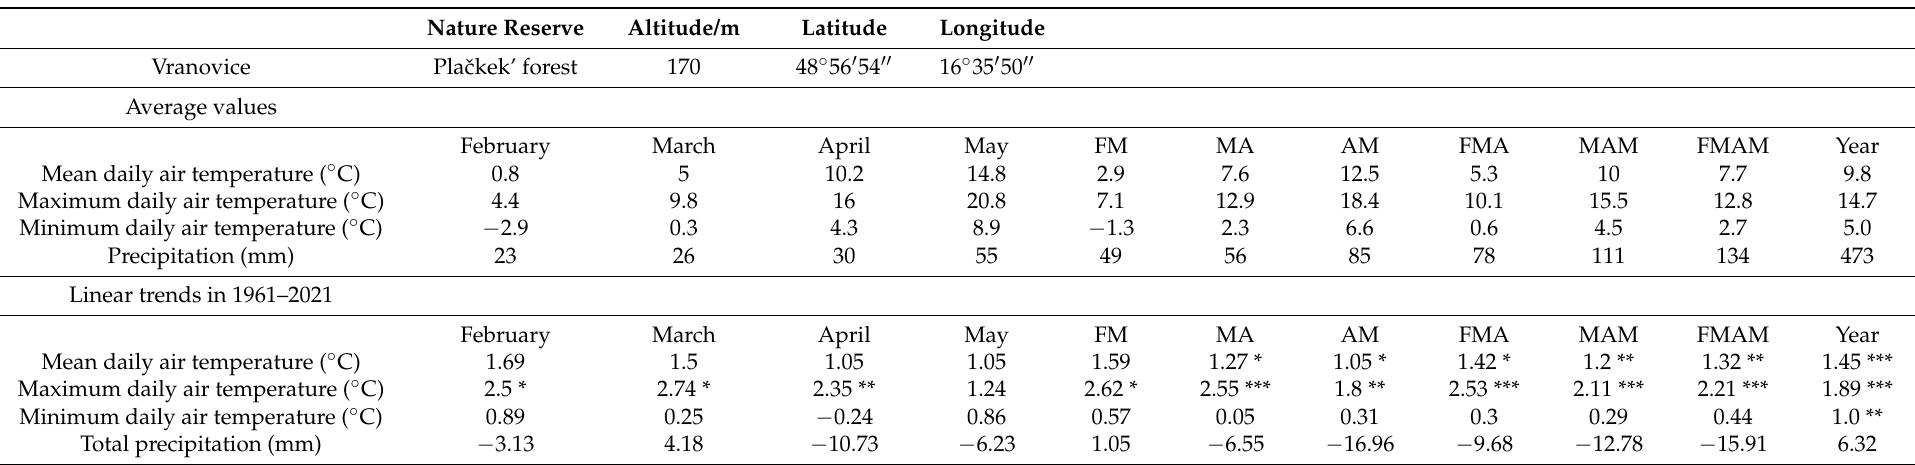
Table 1. Average mean air temperature and the sum of precipitation for the experimental site and linear trends during 1961–2021 for mean, maximum and minimum temperature, and the sum of total precipitation. FM indicates the average for months February and March; MA for March and April; AM for April and May;